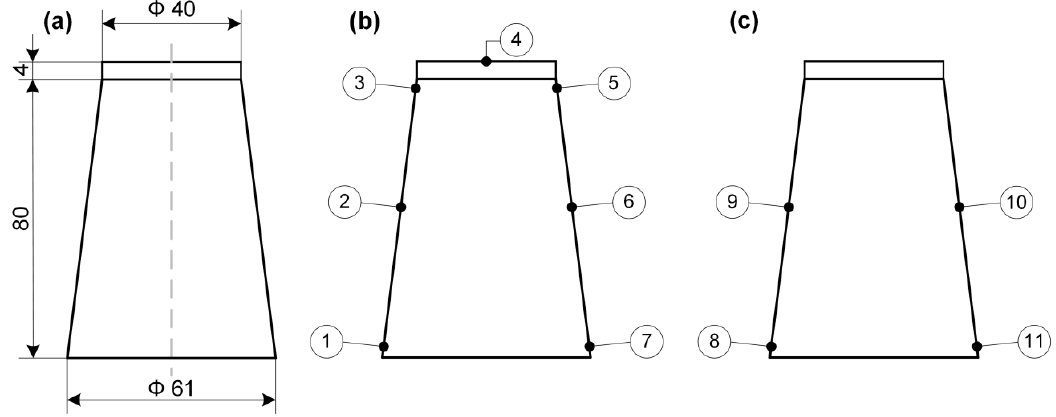
Figure 6. The main dimensions of plug-assist ( a ), the thermoformed cup and indication of points for thickness measurements in the extrusion direction (no. 1–7) ( b ), and indication of points for thickness measurements in the transferred direction to extrusion (no. 8–11) ( c ).